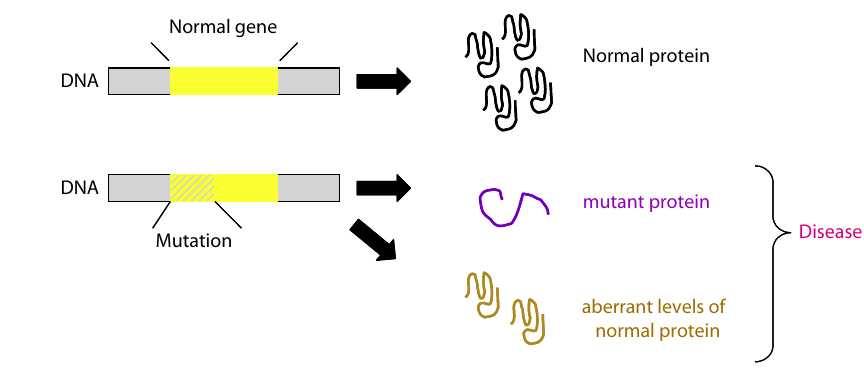
Figure 9. From mutation to disease. A DNA mutation can cause qualitative or quantitative changes at the protein level, leading to either a dysfunctional/non-functional protein product and/or aberrant protein expression levels. Both mechanisms can in turn lead to